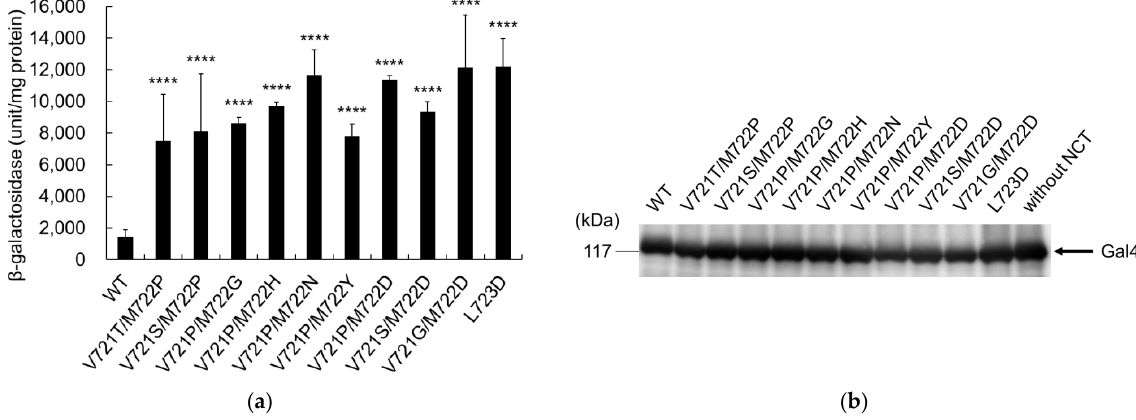
Figure 4. β-Galactosidase activity of APP with only secondary mutations. ( a ) β-Galactosidase activity of the cells expressing either WT or mutant APPC55-Gal4p was assayed as in Figure 3. Activity was normalized to that of control cells without nicastrin (30 units/mg protein). Asterisks indicate p < 0.0001 (****) compared to the WT; ( b ) Expression of WT or mutant APP in yeast. Cell lysates from the WT or mutant APP were analyzed using immunoblot analysis, as in Figure 3. The arrow indicates the position of Gal4.